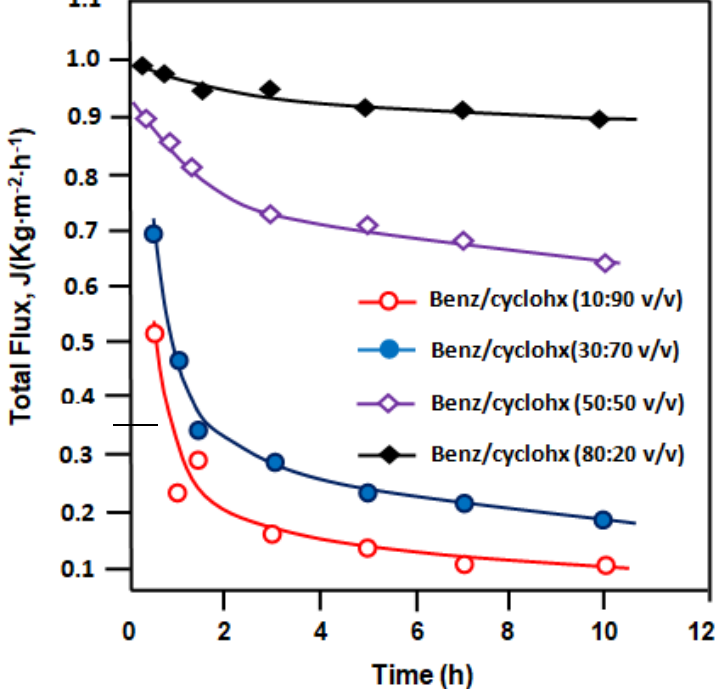
Figure 12. Change in the permeate total flux for benzene / cyclohexane mixtures with di ff erent compositions versus time using the E-VOH / CNT-membrane.